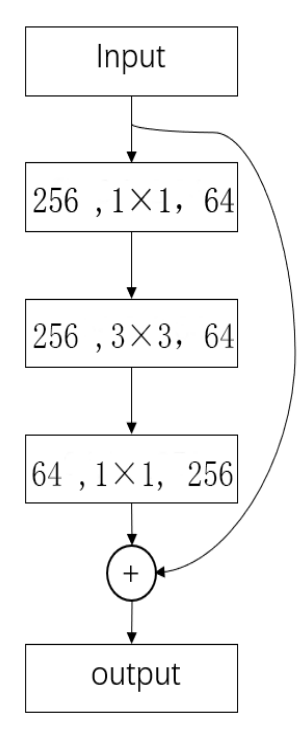
Figure 1. Block of ResNet.